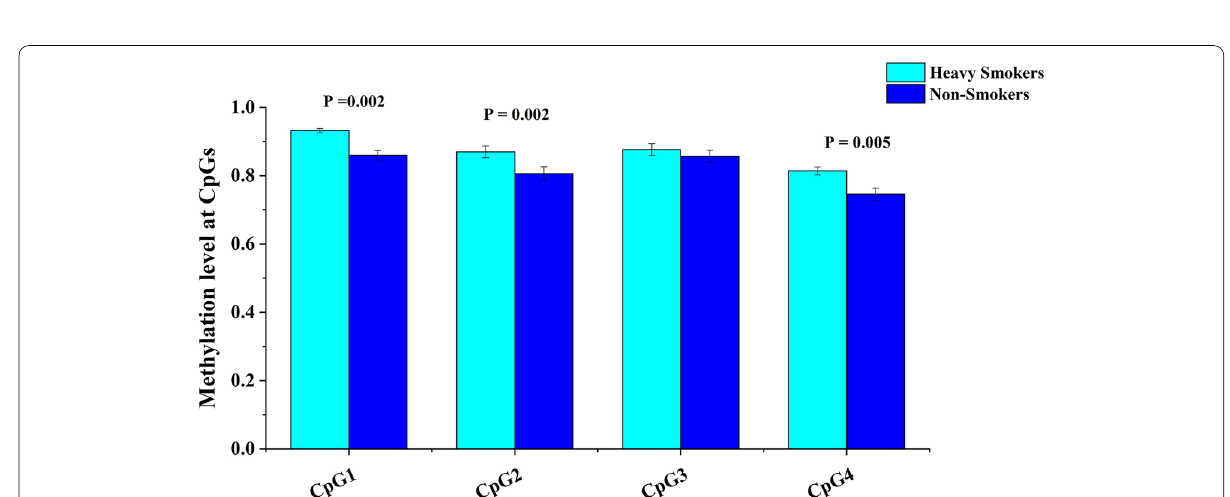
Fig. 5 Methylation level at CpGs within ANXA2 gene-related amplicon in heavy smokers compared to non-smokers. P < 0.05: significant; P not